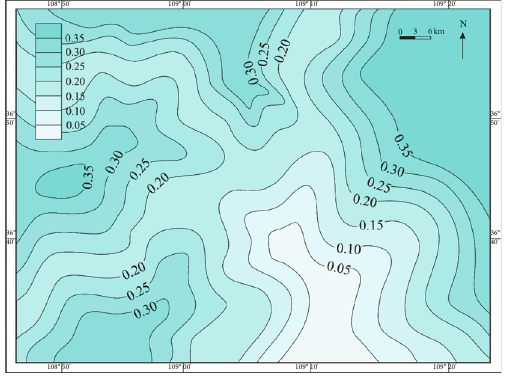
Figure 11: Distribution map of (Cl − -Na + )/Mg 2+ ratios; the contour line represents speci fi c numerical